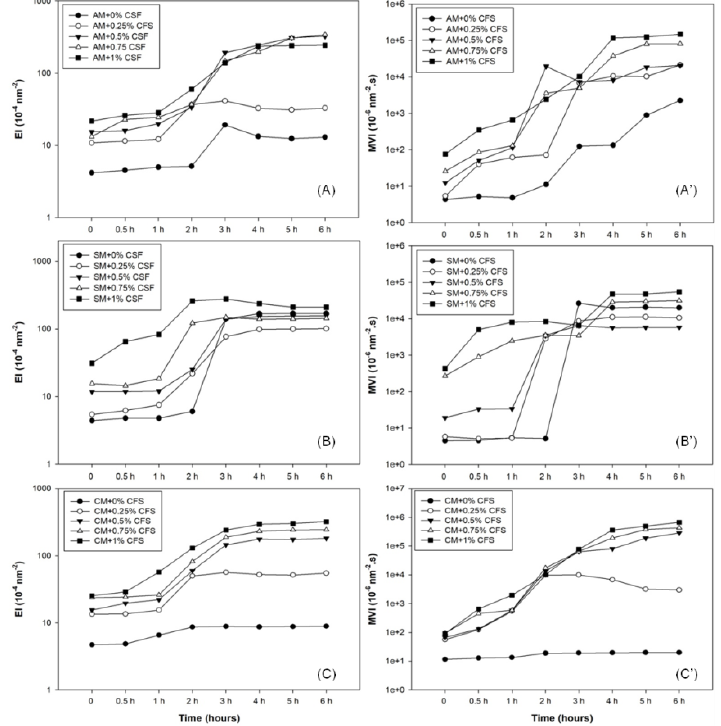
Figure 1. Elasticity index (EI) and macroscopic viscosity index (MVI) values for almond milk ( A , A’ ), soy milk ( B , B’ ) and coconut milk ( C , C’ ) during the fermentation process. The results are the mean of three experiments. Table 2. Solid–liquid balance (SLB) before and after fermentation process. The results are the mean of three experiments ± standard deviation. (* p value < 0.05; ** p value <